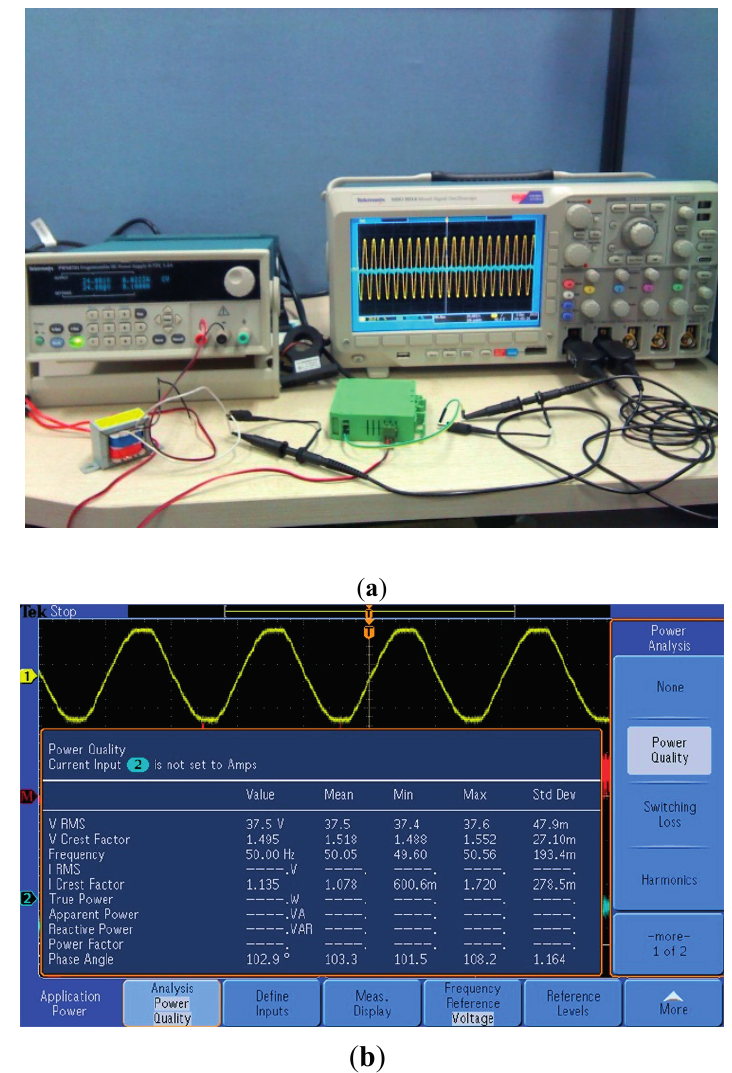
Figure 10. The calibration of the voltage and current sensors via the digital